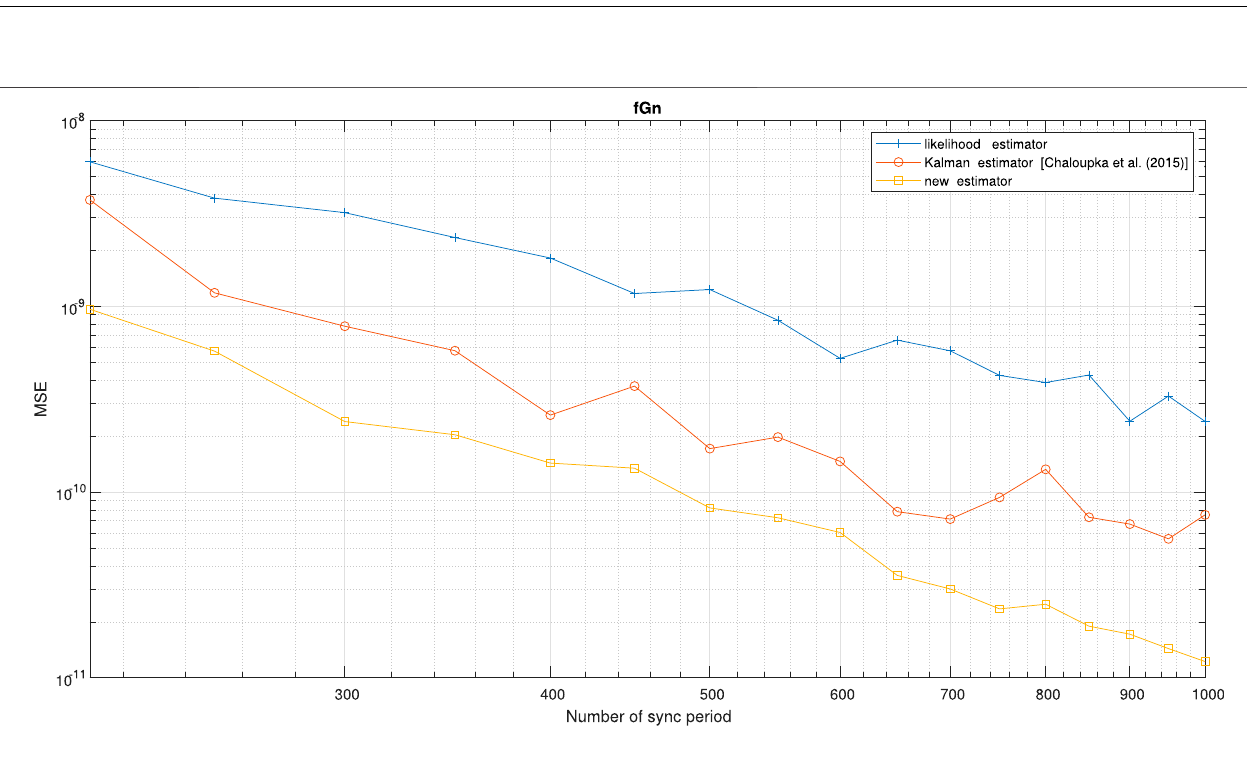
FIGURE 12 | Performance comparison between the new clock skew estimator Eq. 3 for the fGn case with the clock skew estimator of Noh et al. [34] and Chaloupkaetal.[36].TheclockskewestimatorofNohetal.[34]isdenoted hereasthelikelihoodestimator. α (cid:1) 50 ppm , Q (cid:1) 5 ms , T syn (cid:1) 15.6 ms , σ ω d ms (cid:1) 5 ms , d sm (cid:1) 5.5 ms , H (cid:1) 0.7, L (cid:1) 200, Q KAL (cid:1) 0, δ σ (cid:1) δ μ (cid:1) 1 e − 4, ^ μ [ 1 ] (cid:1) 0. The results were obtained for 50 Monte-Carlo trails.